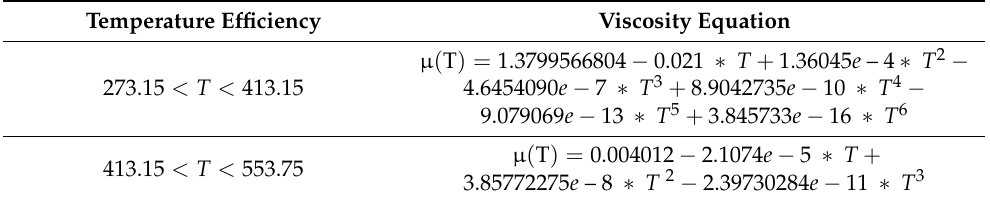
Table 3. Effects of temperature on viscosity of water [79].